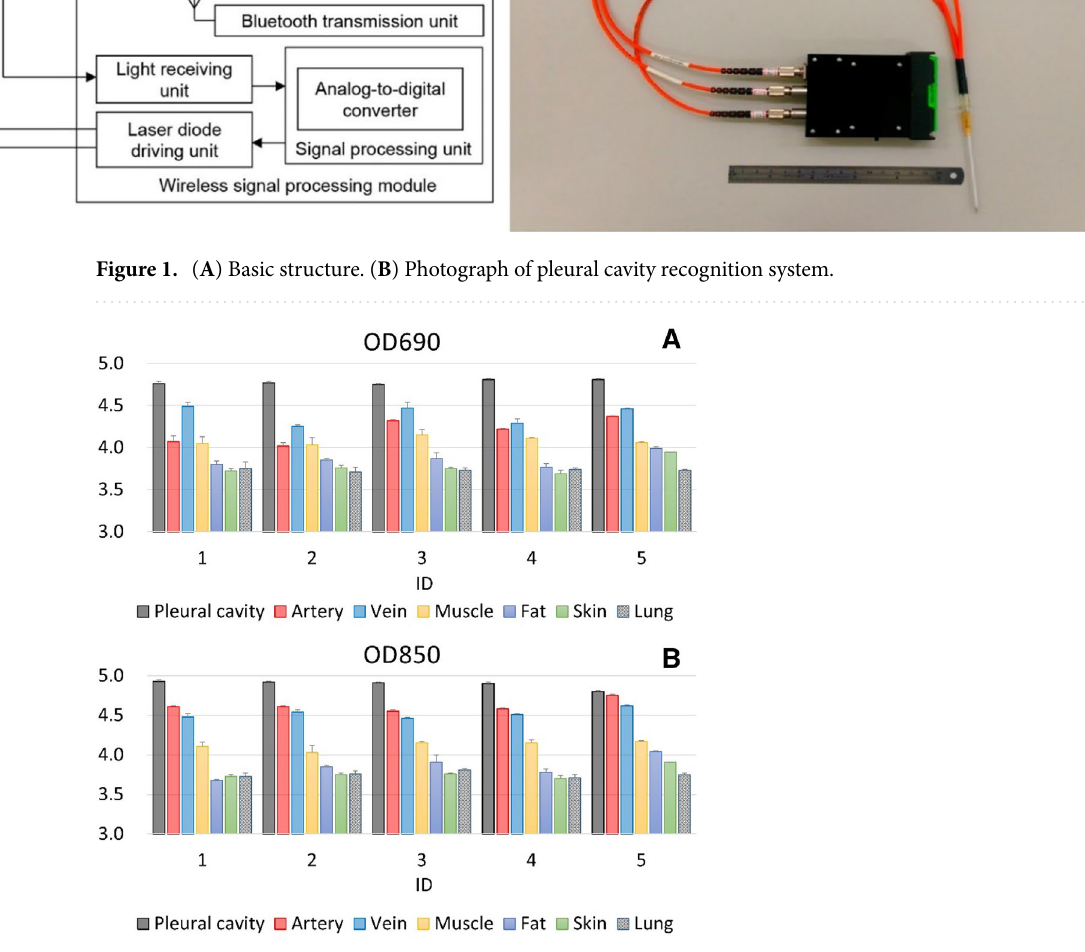
Figure 2. ( A ) 690-nm optical density change and ( B ) 850-nm optical density change in different tissue